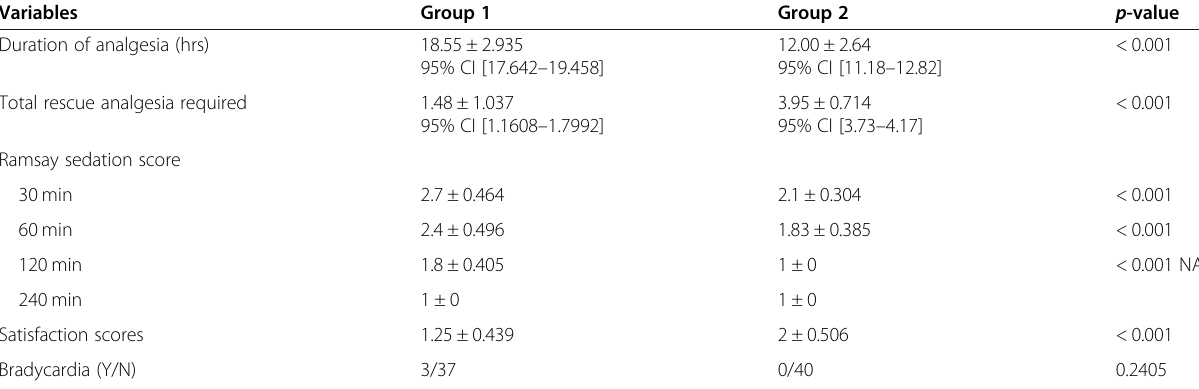
Table 2 Comparison of duration of analgesia, total rescue analgesic doses administered, Ramsay sedation score, patient satisfaction scores, and bradycardia in both groups Variables